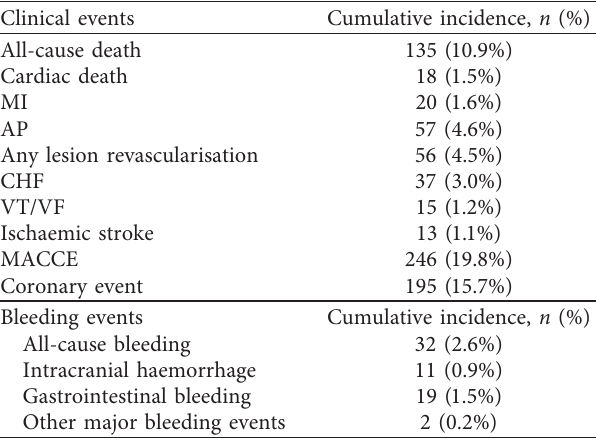
Table 2: Clinical events during follow-up of patients with ischaemic heart